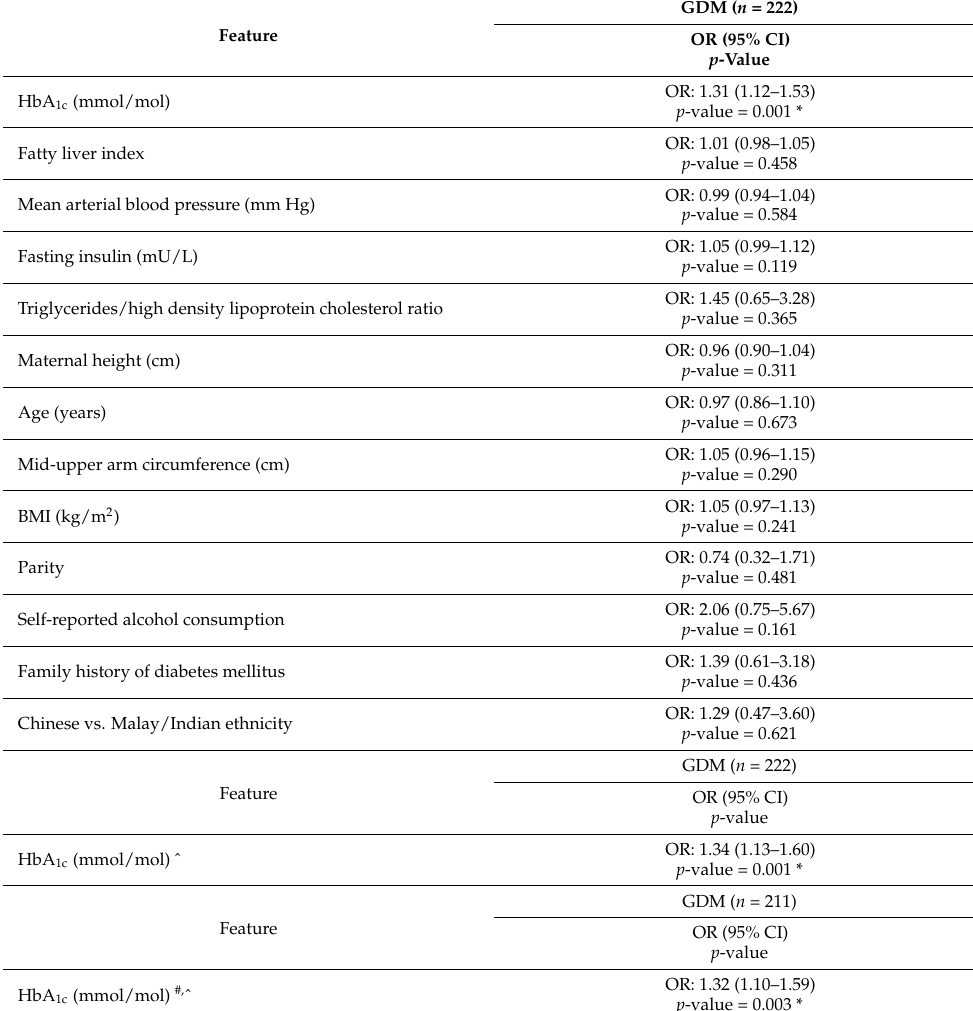
* Statistically significant feature. ˆ Adjusted for maternal ethnicity, age, parity, family history of diabetes mellitus and pre-pregnancy BMI. # After excluding 11 women with prediabetes (impaired glucose tolerance) based on preconception